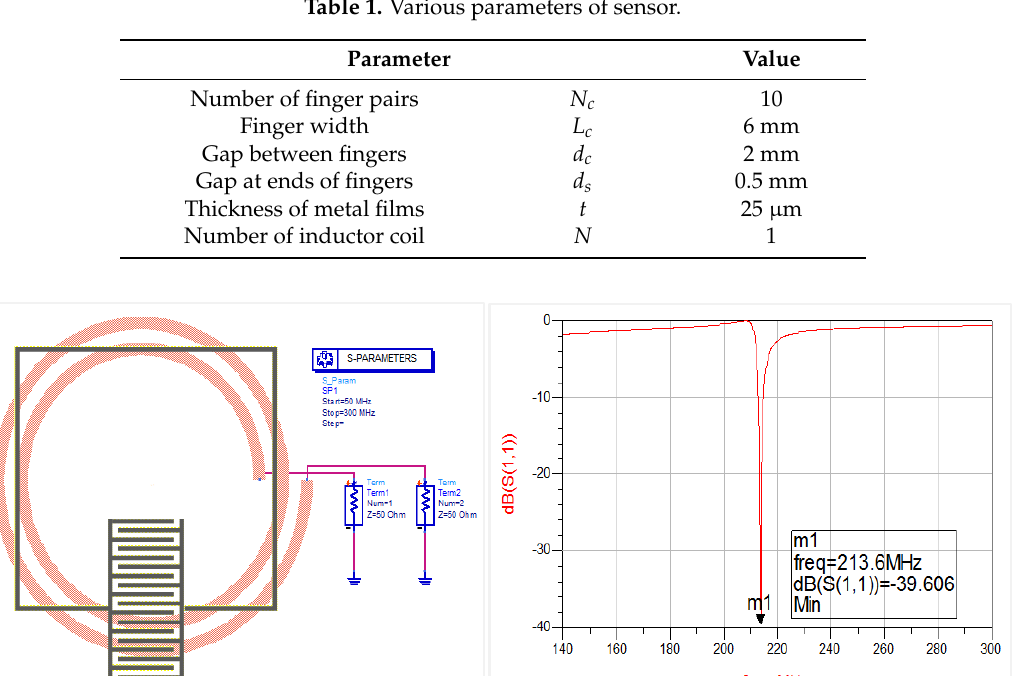
Figure 3. ADS simulation results over the bandwidth of 50 – 300 MHz, which is consistent with the range used experimentally. Resonance occurs when the frequency of the sweep signal is close to the natural frequency of the sensor at the minimum value of input return loss S (1,1). The theoretical resonant frequency of interdigital capacitor wireless passive gas sensor is found to be 213.6 MHz, with an input return loss of − 39.61 dB.